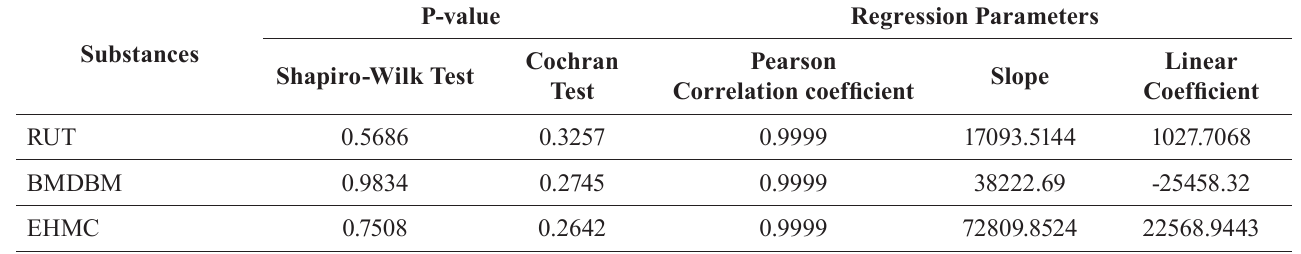
TABLE II - P-values obtained for the tests of normality of residues (Shapiro-Wilk Test) and homoscedasticity (Cochran Test) ( α = 0.05) and regression parameters obtained from the analytical curves of rutin, BMDBM, and EHMC